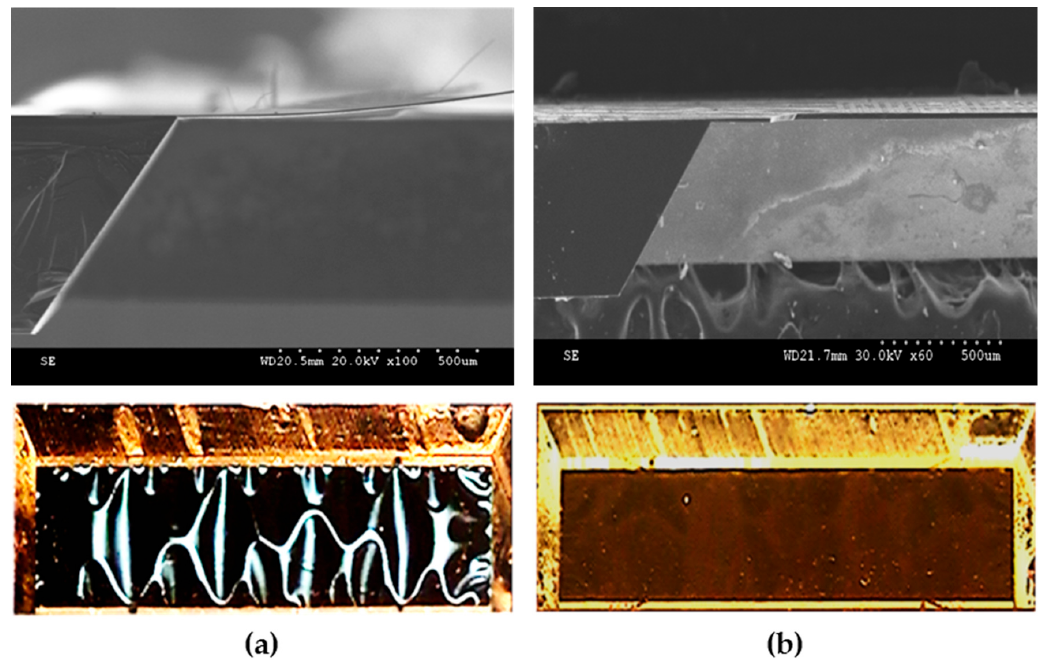
Figure 5. Cross-sectional SEM and bottom-view optical micrographs of the implemented FPW device using the ( a ) 80 °C and ( b ) 60 °C/27 °C two-step low-temperature anisotropic silicon etching processes.